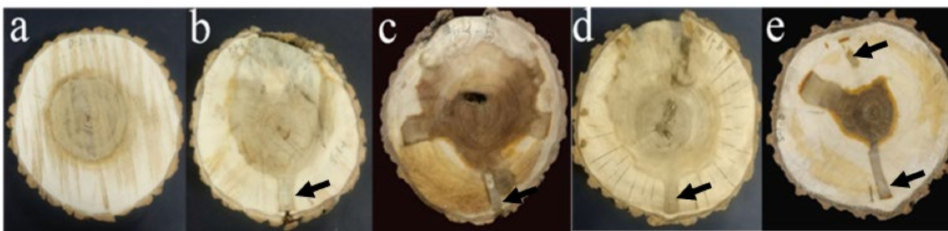
Figure 2. Macroscopic pictures of the cross section of Populus euramevicana discs ( a ) for the unmodified poplar disc, ( b – d ) for the 1, 10, 100 mmol/L TEOS injection group and ( e ) for the SiO 2 colloid modified poplar disc. The black arrow represents the injection